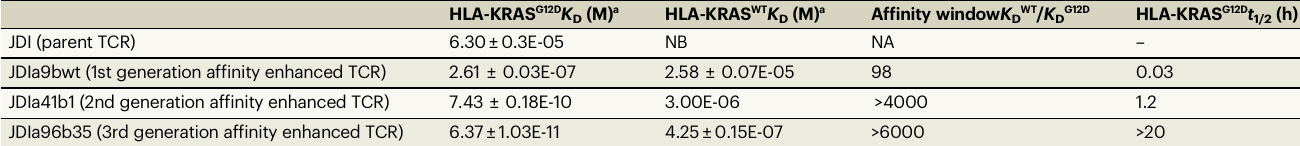
Table 2 | Binding af fi nity of parent and various af fi nity enhanced TCRs to HLA-A*11:01 presented KRAS WT and KRAS G12D peptides